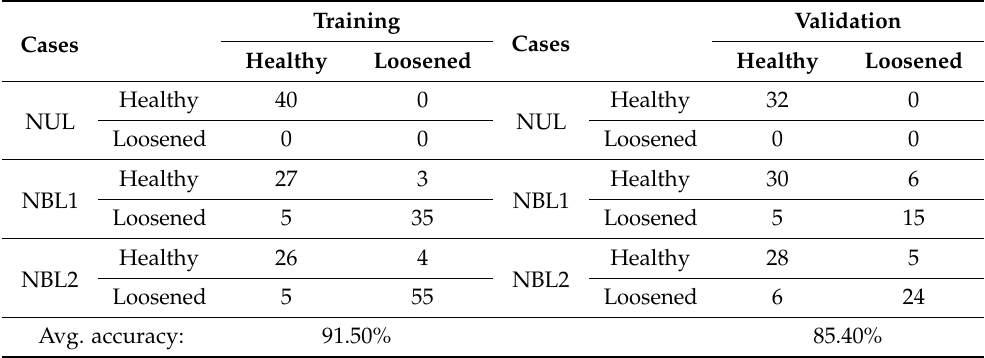
Table 9. Confusion charts show the average training and validation accuracy for four storey numeri- cal model.